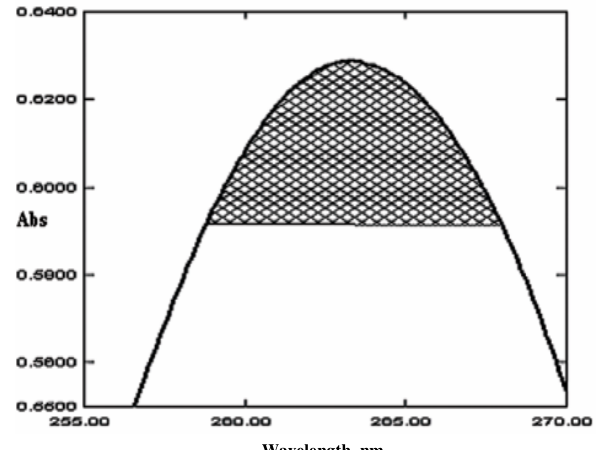
Wavelength, Figure 2. UV-spectrum for area under curve (AUC) of gemifloxacin mesylate, 4 µ L/mL from 258.8-268.8 nm.